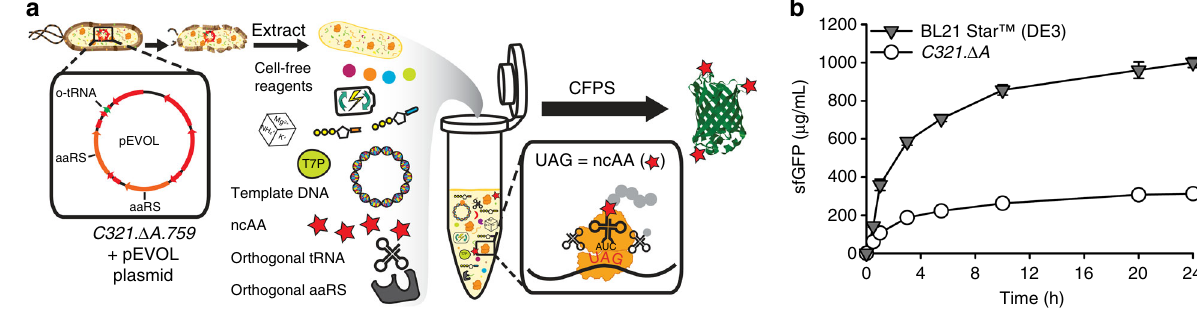
Fig. 1 CFPS from extracts of a genomically recoded organism. a Schematic of the production and utilization of crude extract from genomically recoded organisms with plasmid overexpression of orthogonal translation components for cell-free protein synthesis (CFPS). CFPS reactions are supplemented with the necessary substrates (e.g., amino acids, NTPs, etc.) required for in vitro transcription and translation as well as puri fi ed orthogonal translation system (OTS) components to help increase the ncAA incorporation ef fi ciency. aaRS, aminoacyl tRNA synthetase; ncAA, non-canonical amino acid; T7P, T7 RNA polymerase; UAG, amber codon. b Time course of superfolder green fl uorescent protein (sfGFP) synthesis catalyzed by extracts derived from a genomically recoded organism, C321 . Δ A , and a commercial strain, BL21 Star (DE3). Three independent batch CFPS reactions ( n = 3) were performed at 30 °C for each time point over 24 h. Error bar = 1